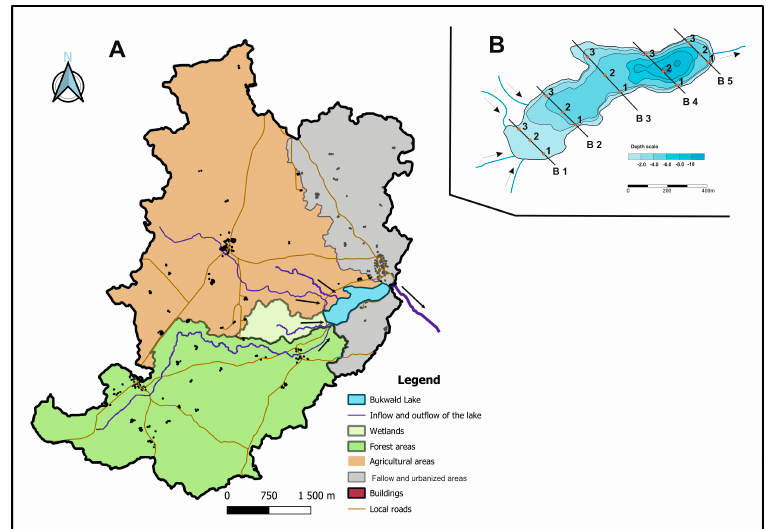
Figure 1. Land use in the catchment area of Lake Bukwa ł d ( A ). The location of sediment sampling sites is shown on the bathymetric map of Lake Bukwa ł d ( B ). sites is shown on the bathymetric map of Lake Bukwałd ( B